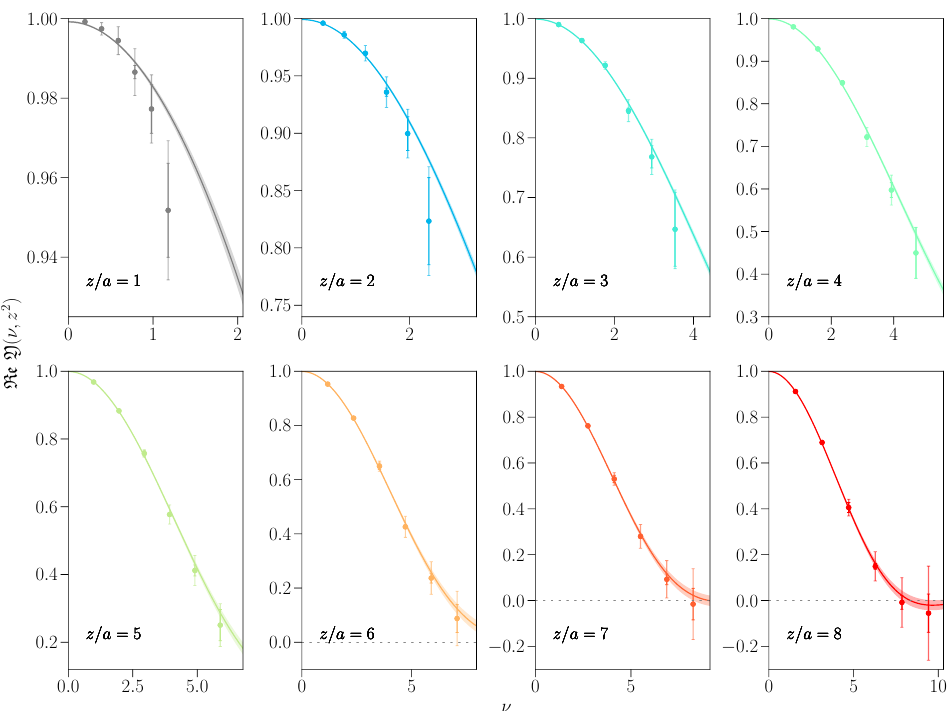
(cid:0) (cid:1) ν, z 2 obtained from summed